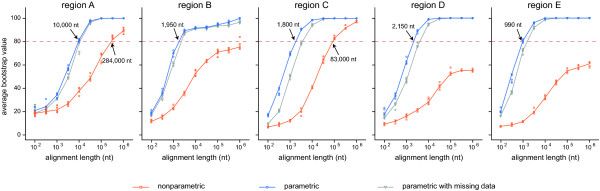
Estimated data requirement for resolving the five poorly supported regions. Each graph shows how average bootstrap support increases as a function of alignment length for three types of simulations: nonparametric resampling of the empirical alignment (orange), parametric simulation of data (blue) and parametric simulation followed by introduction of missing data (gray). The approximate amount of data required to resolve a region can be derived for each simulation type by specifying a desired level of bootstrap support (e.g., the dashed line drawn at 80) and deducing the corresponding alignment length on the x-axis. Note that the x-axis uses a logarithmic scale. The lines connect the means of the five values of each condition.